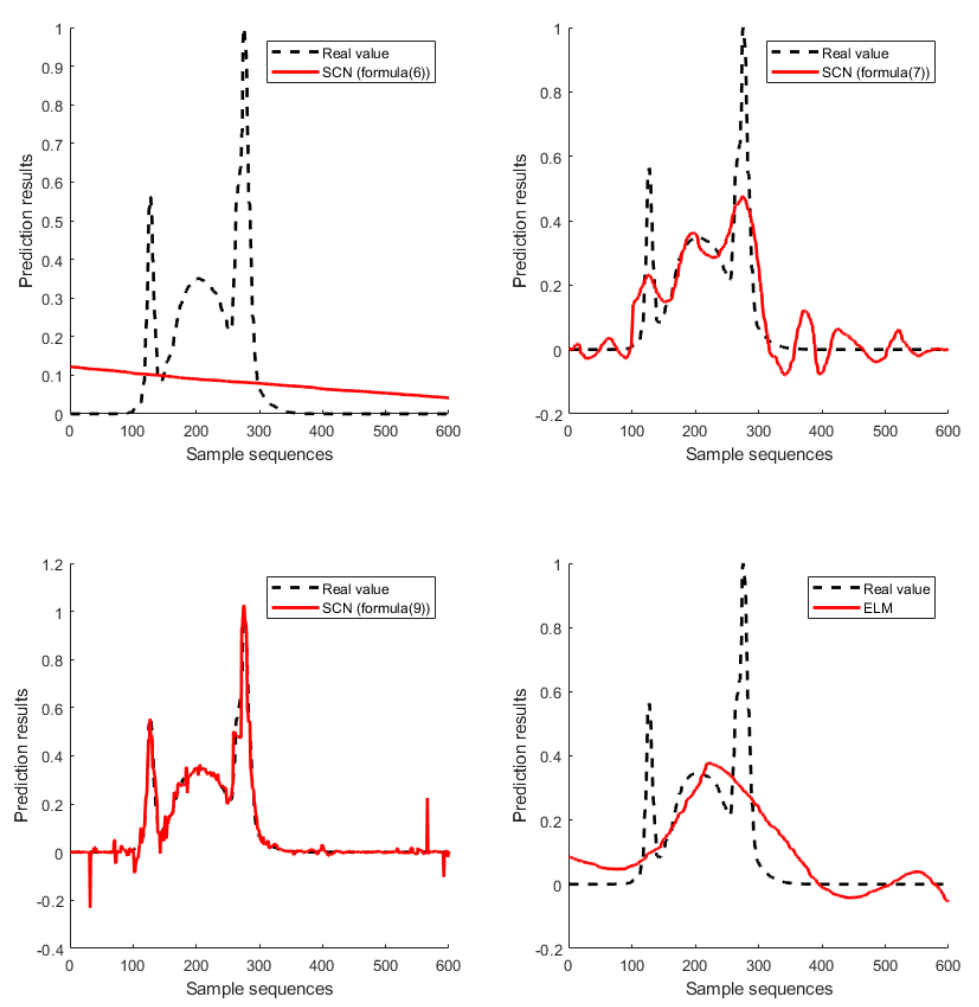
Figure 4. Comparison of SCN (Formulas (6), (7), (9)) and ELM implementation on the simulation data set.